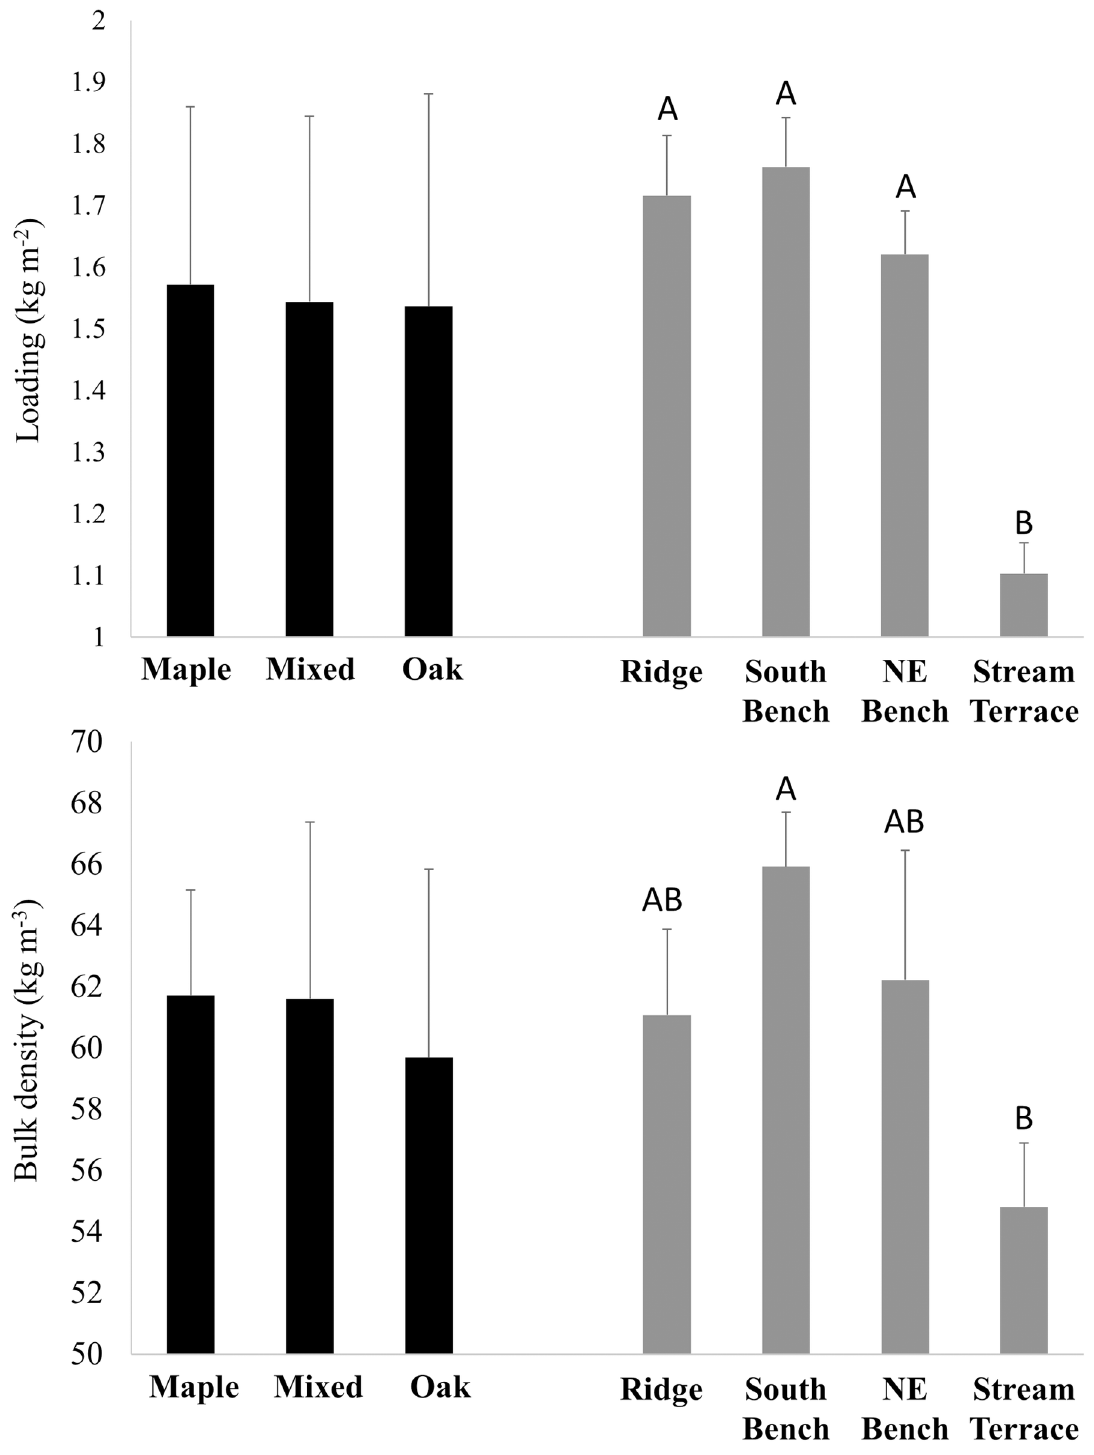
Fig 5. Common garden fuel loading and bulk density – H layer. Loading and bulk density by litter source and topographic position in common garden beds after four years of fall litter additions (see means in Table 3). Beds were sampled during the transition between winter and spring when most prescribed burning occurs. Only topographic effects were significant and differences among means were determined by Tukey ’ s HSD method and are indicated by different letters. Standard errors are